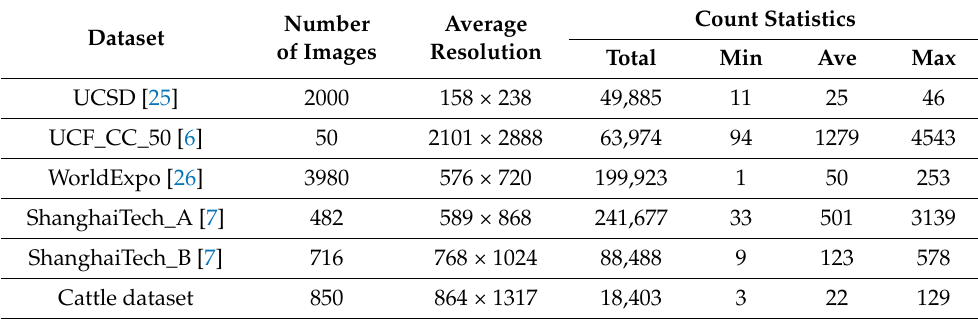
Table 1. Statistics of different crowd counting datasets and cattle counting dataset.